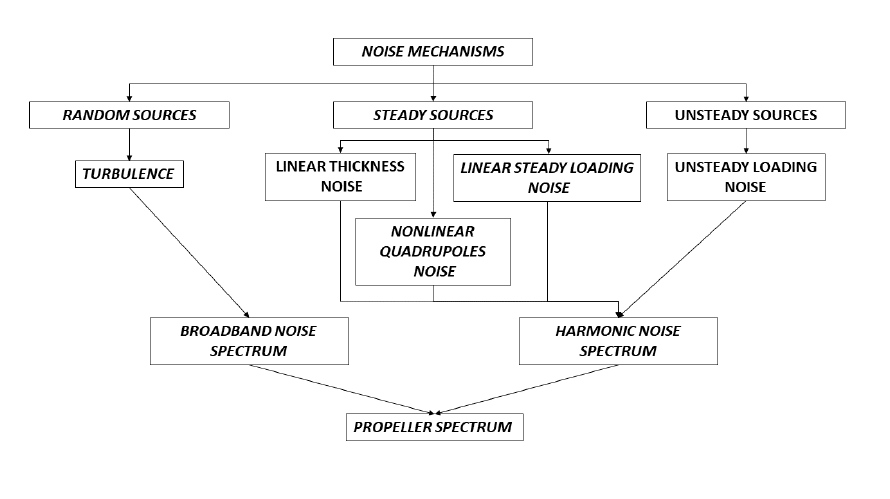
Figure 2. Noise generation contributions to typical propeller